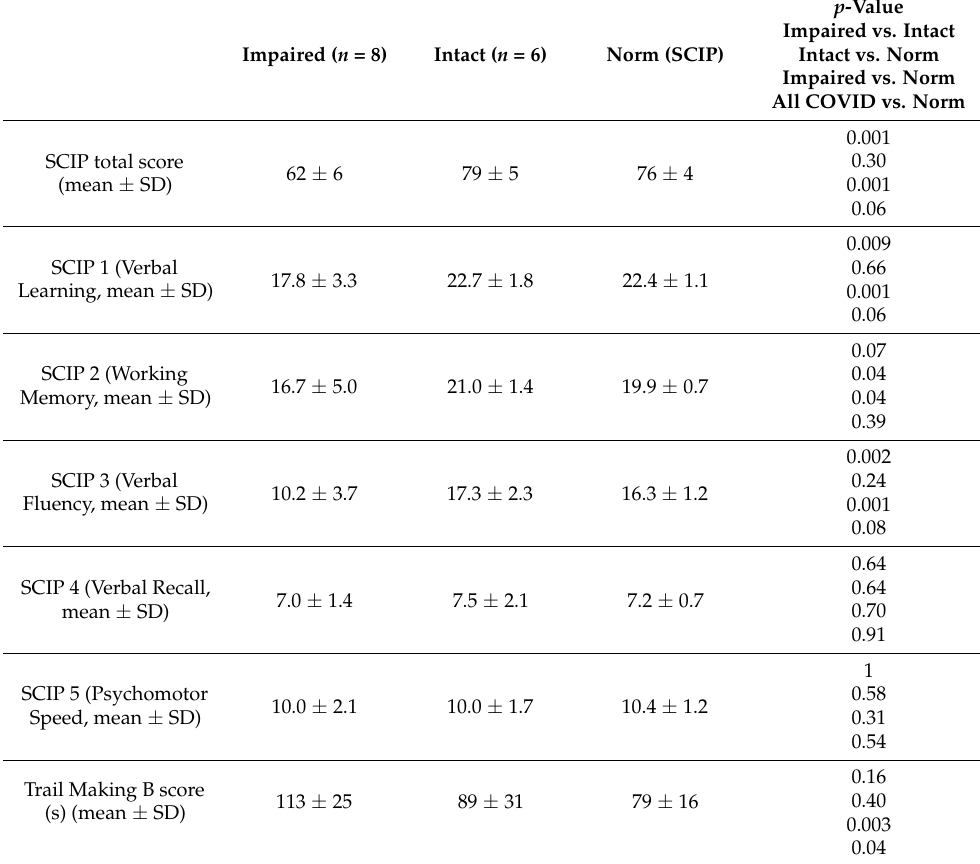
Table 3. Cognitive test results in cognitively impaired, intact and Norm (SCIP) based on age, education and sex norms [29].